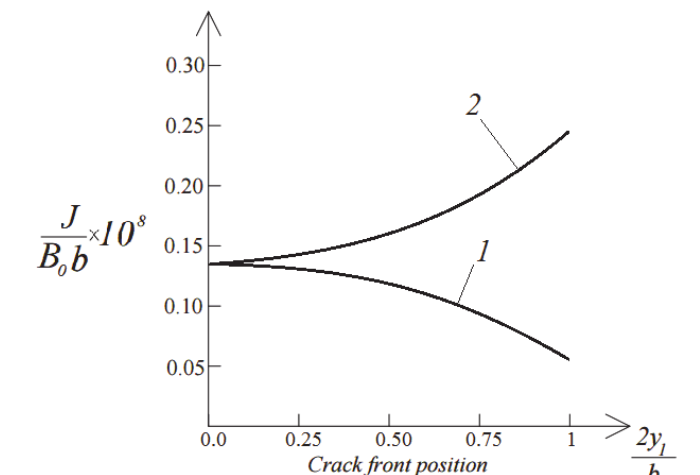
Figure 5: The distribution of the J -integral value in non-dimensional form along the crack front (curve 1 - at 1 0 / 1.2 B